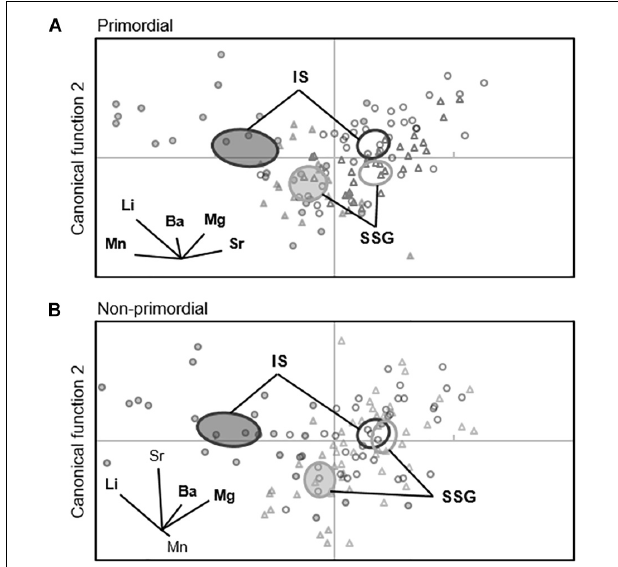
FIGURE 10 | Canonical variate plots of the multi-elemental chemistry for the (A) primordial area and (B) non-primordial area of larval King George whiting otoliths in 2017 (shaded) and 2018 (open). Ellipses show 95% confidence around group means. Vector diagrams show the direction and weight of individual elements to sample distribution. Elements in bold contribute most to group differences. SSG, Southern Spencer Gulf ( (cid:78) , light); IS, Investigator Strait ( • , dark).